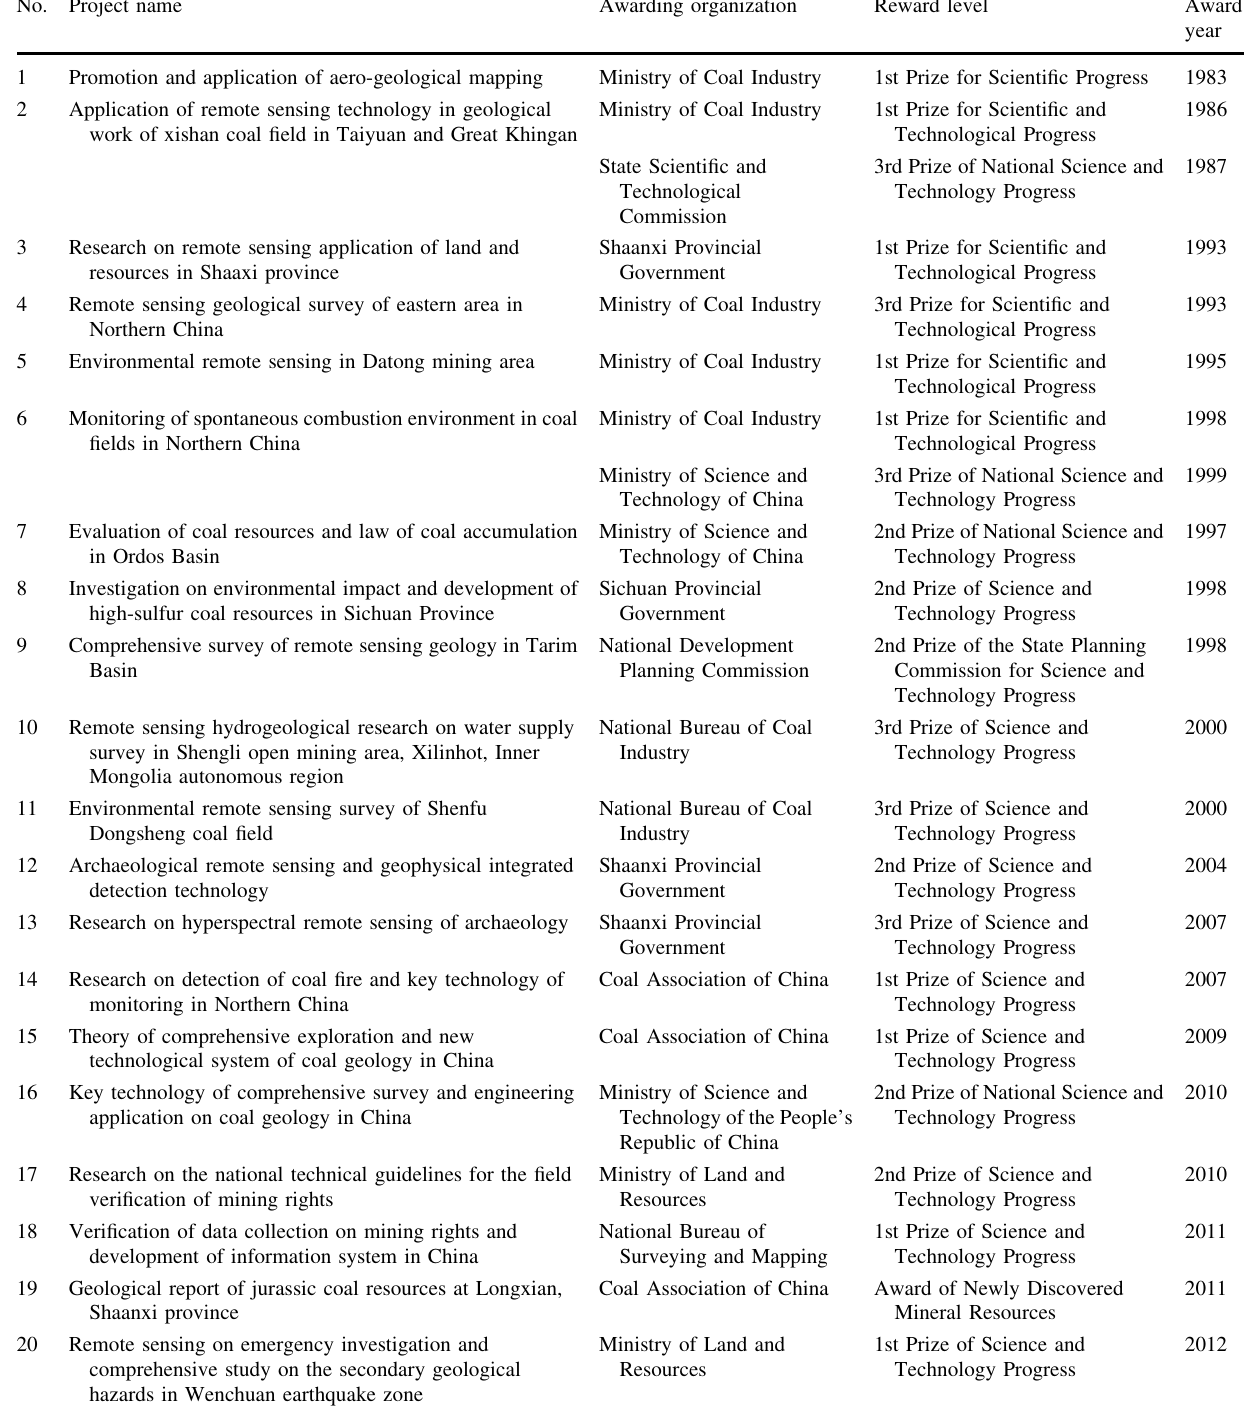
Table 1 Main science and technology awards obtained by ARSC in coal remote sensing technology No. Project